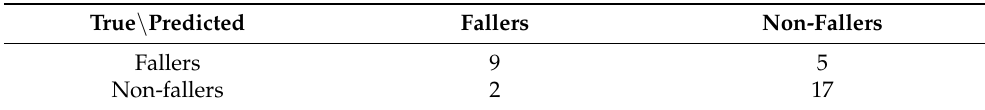
Table 3. Confusion matrix of the classification results of the test performed using actual data using the model tuned for the